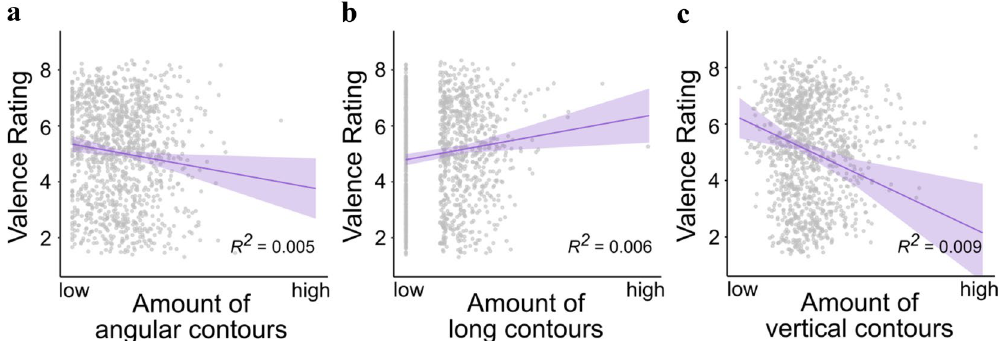
Figure 2. Partial regression plots of the three significant predictors. a Average valence ratings of IAPS photographs as a function of the number of pixels belonging to highly angular contours in that image; b Average valence ratings as a function of the number of pixels belonging to long contours in that image; c. Average valence ratings as a function of the number of pixels belonging to vertical contours in that image. Valence ratings ranged from 1 (“unhappy”) to 9 (“happy). The grey dots in each graph represent individual images. The shaded areas show 95% confidence intervals.